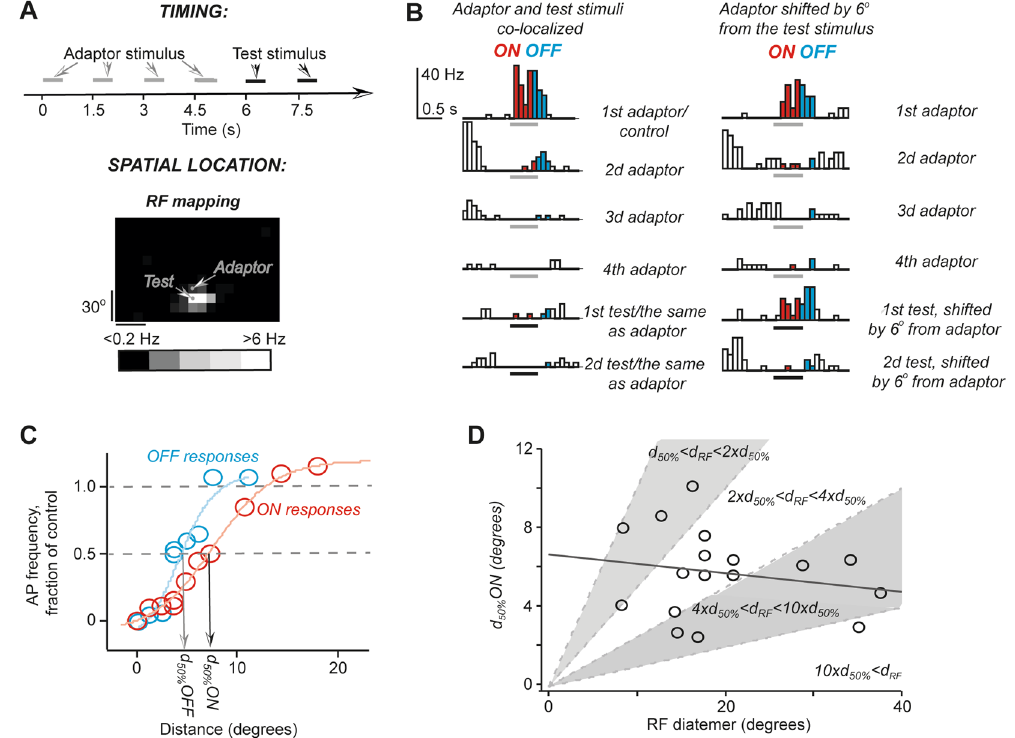
Figure 4. Slow adaptation can be eliminated by shifting the adaptor stimulus within RF. ( A ) A schematic representation of stimulation paradigm. ( B ) An example of responses obtained for co-localized adaptor and test stimuli (left column of PSTHs) and for adaptor presented in location, which was shifted to a distance close to d 50% . Scale bar: 40 Hz and 0.2 s. ( C ) The summary of ON and OFF responses of the unit shown in ( B ) Normalized response amplitude is plotted against adaptor location distance from the test stimulus location. ( D ) A plot of d 50% against RF diameter to demonstrate the lack of correlation between RF size and d 50% . Each open circle in the plot corresponds to one unit. The graph area is divided into regions of different ranges of RF diameter to d 50% ratios. These ranges are indicated by equations. Note that for all units RF diameter was larger than d 50%